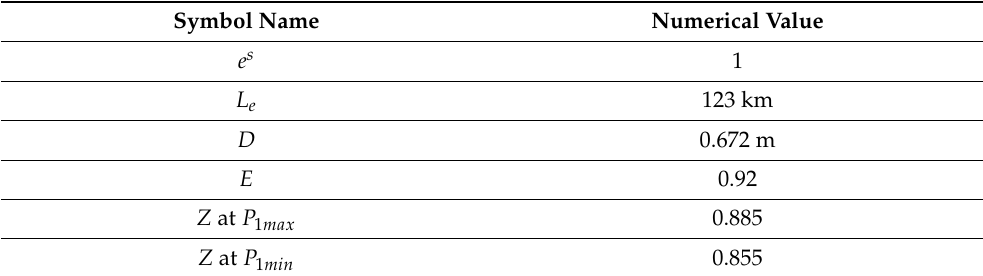
Table 4. The input parameters for Panhandle A